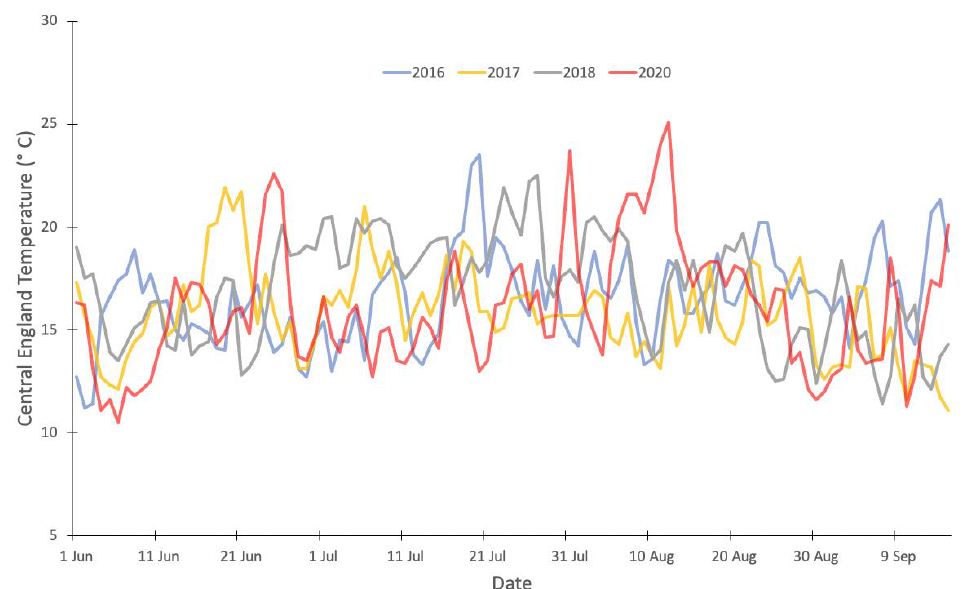
Figure 1. Mean Daily Central England Temperature series for 2016 (blue), 2017 (yellow), 2018 (grey), and 2020 (red).